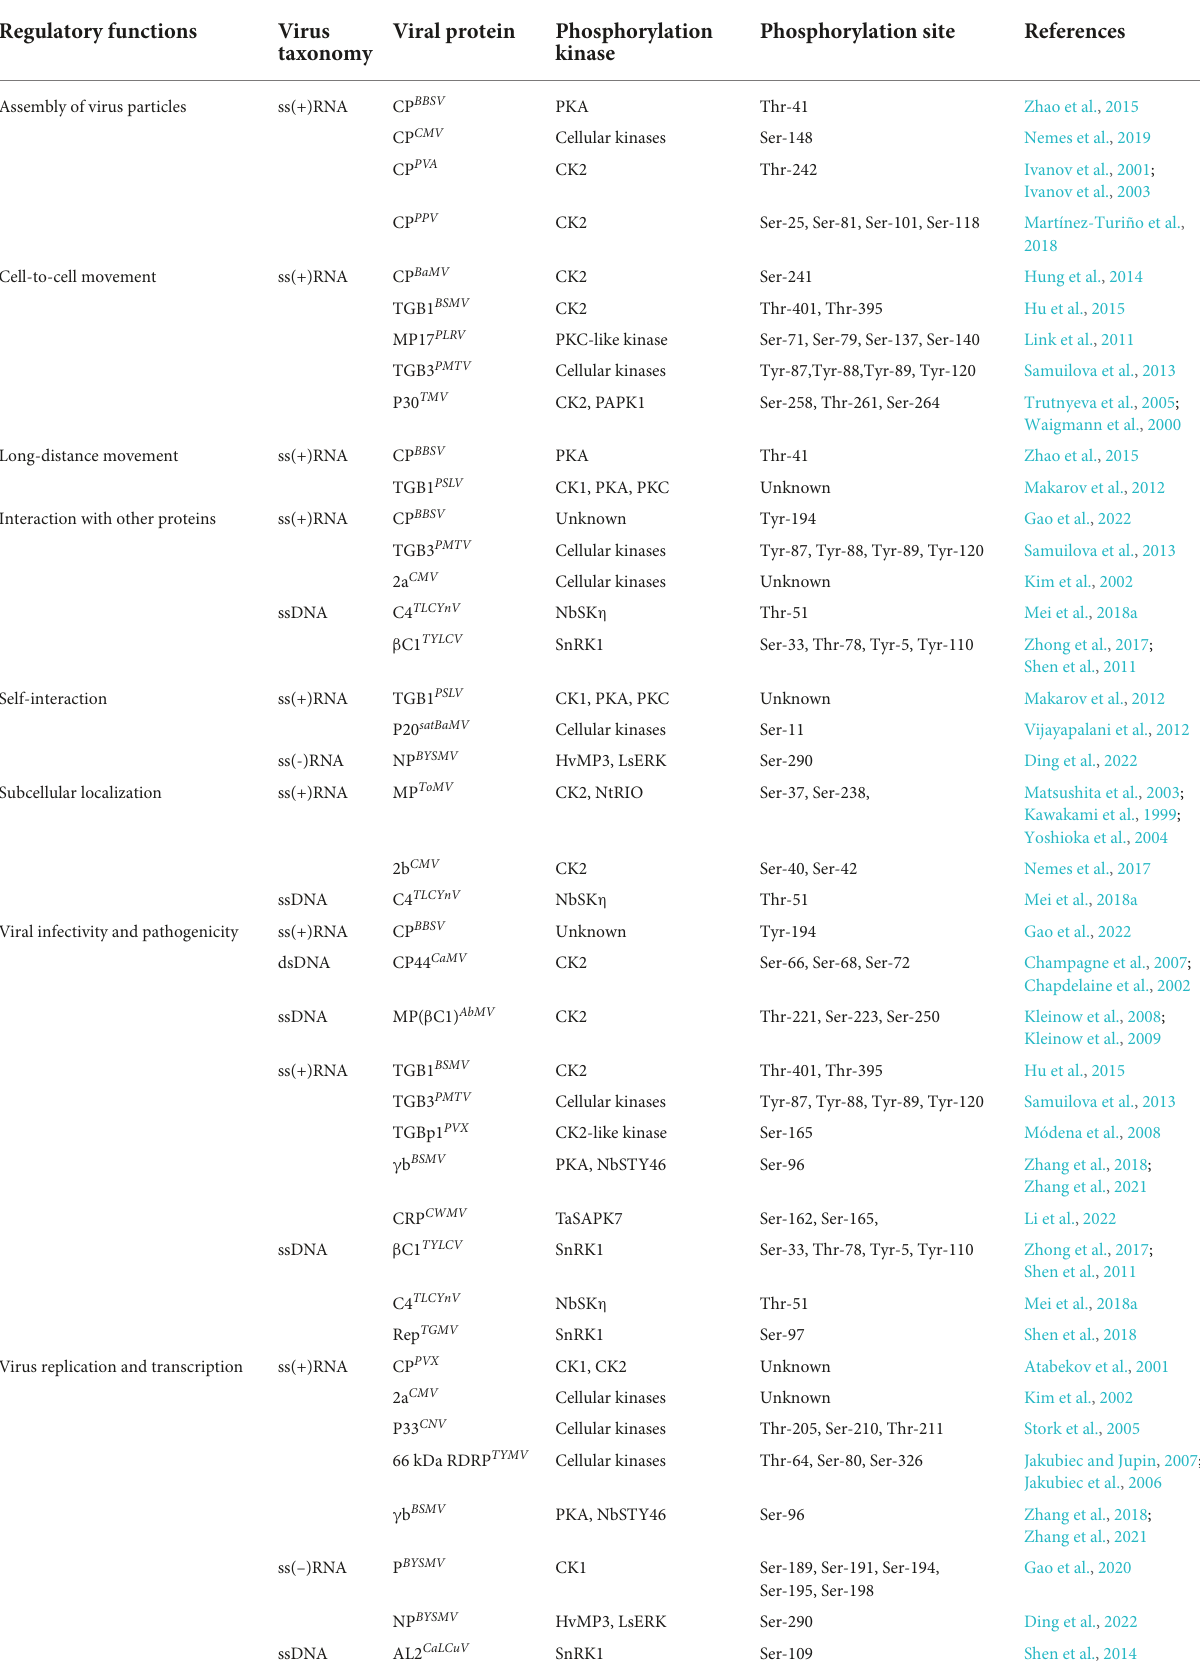
TABLE 2 Phosphorylation modifications of plant virus